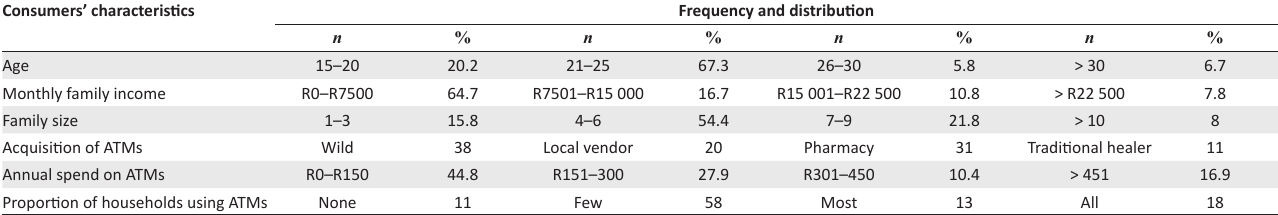
TABLE 1: Summary of respondent demographic characteristics. Consumers’ characteristics